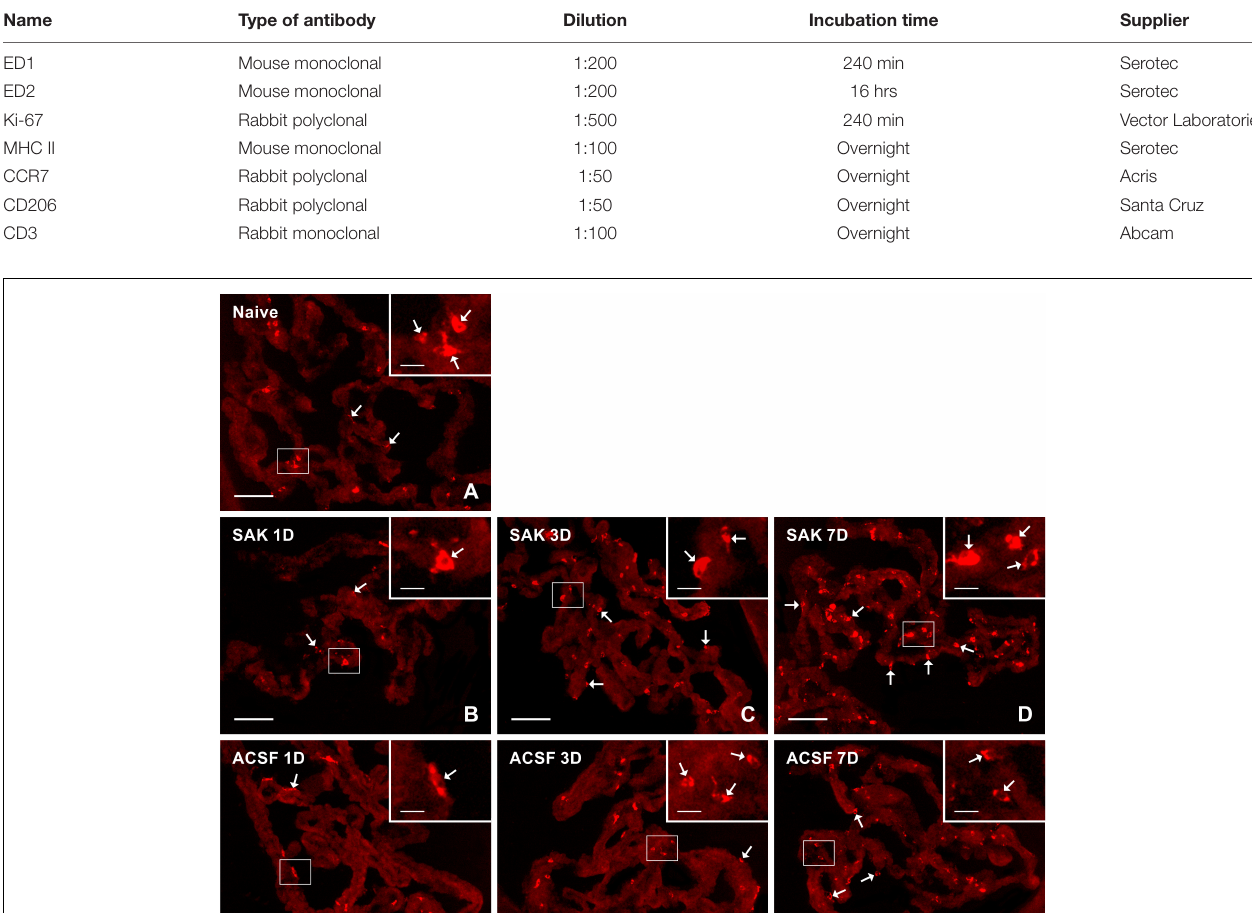
TABLE 1 | List of primary antibodies used, their dilutions, incubation times and suppliers.